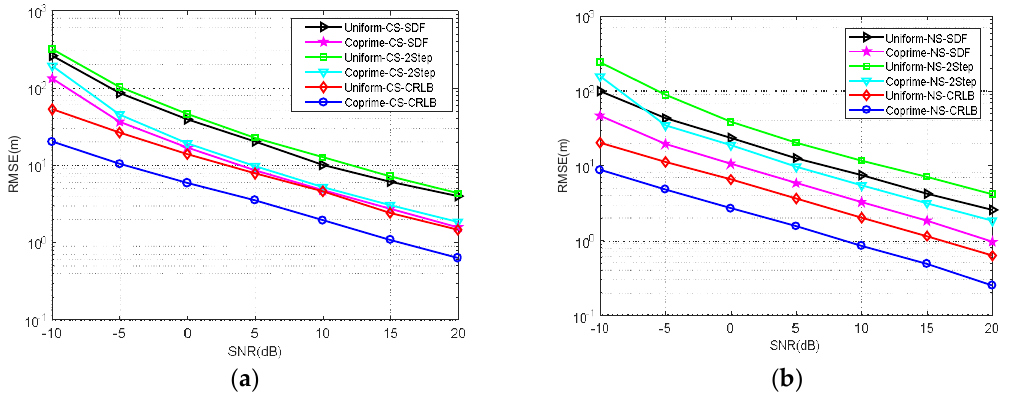
Figure 9. RMSE performance comparison under different SNR ( a ) circular sources ( b ) non-circular sources. Uniform-CS-2Step/Uniform-NS-2step: two-step localization for CS/NS based on uniform array; Coprime-CS-2Step/Coprime-NS-2step: two-step localization for CS/NS based on coprime array; Uniform-CS-CRLB/Uniform-NS-CRLB: CRLB for CS/NS based on uniform array; Coprime-CS-CRLB/Coprime-NS-CRLB: CRLB for CS/NS based on coprime array. Simulation 3. RMSE comparison of MCA-DPD, SDF, two-step localization, and the CRLB under different